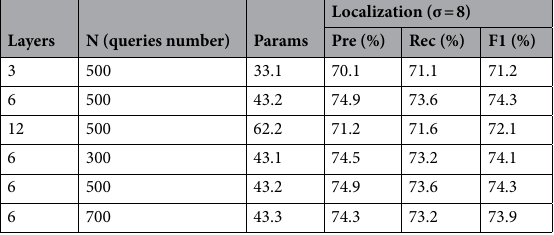
Table 2. Effect of transformer size on ShanghaiTech PartA